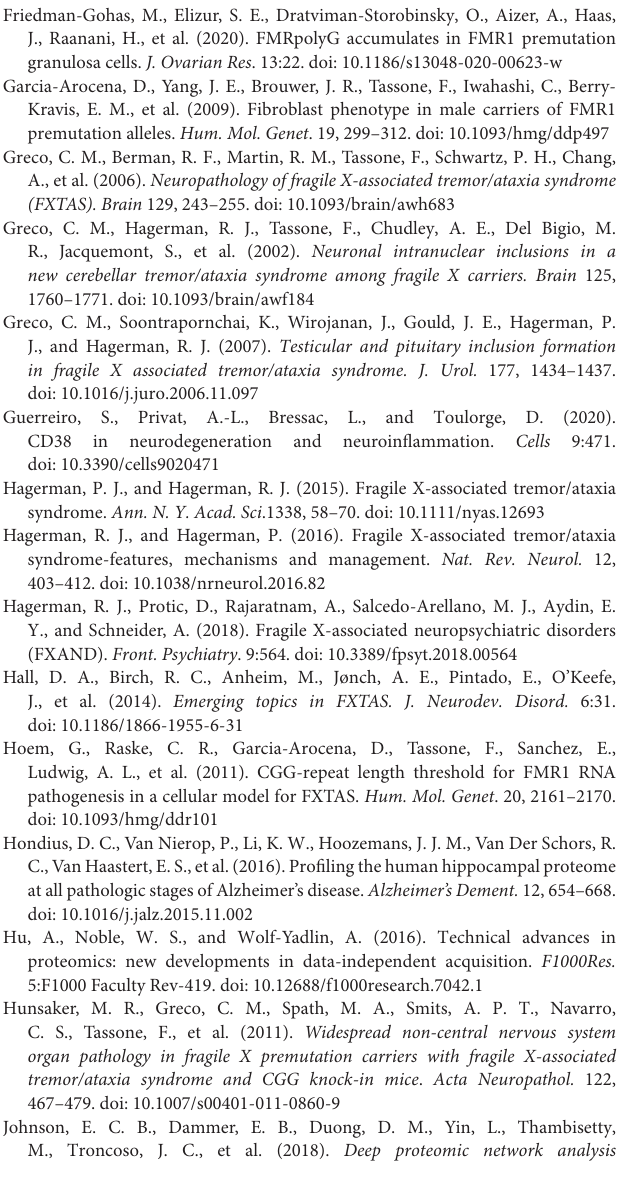
Supplementary Figure 1 | FMRpolyG detected by western blot. SK-N-MC cells transfected with expression plasmid produced FMRpolyG with 63 glycines